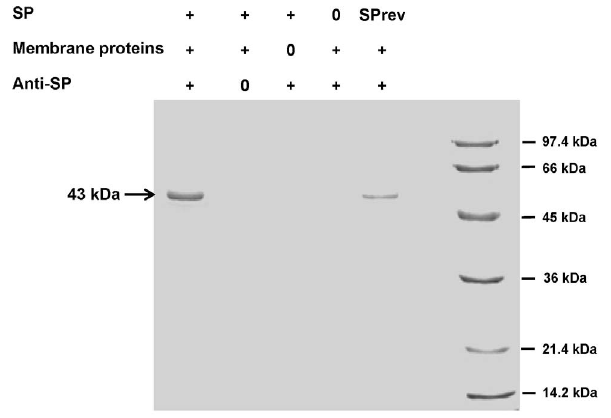
Figure 8. SDS page analysis of Bacilluscereus Substance P (SP) binding proteins separated by immunoprecipitation using SP antibody-associated beads. SP was found able to bind on a 43 kDa protein that was identified by MALDI-TOF/TOF as the Thermo Unstable ribosomal Elongation factor Ef-Tu (arrow: 43 kDa). SPrev was also capable of binding to this protein but with a reduced effectiveness. Results are representative of three independent experiments.